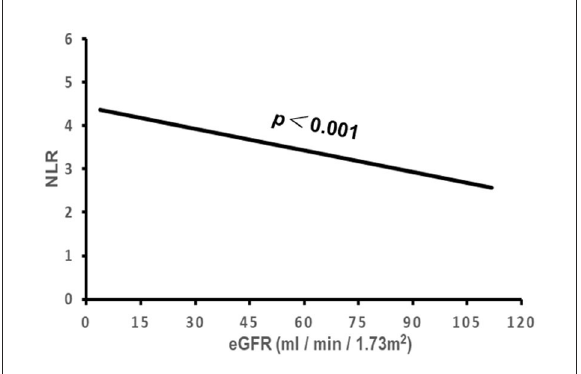
FIGURE4 The association of NLR with eGFR. NLR, neutrophil to lymphocyte ratio; eGFR, estimated glomerular filtration rate.